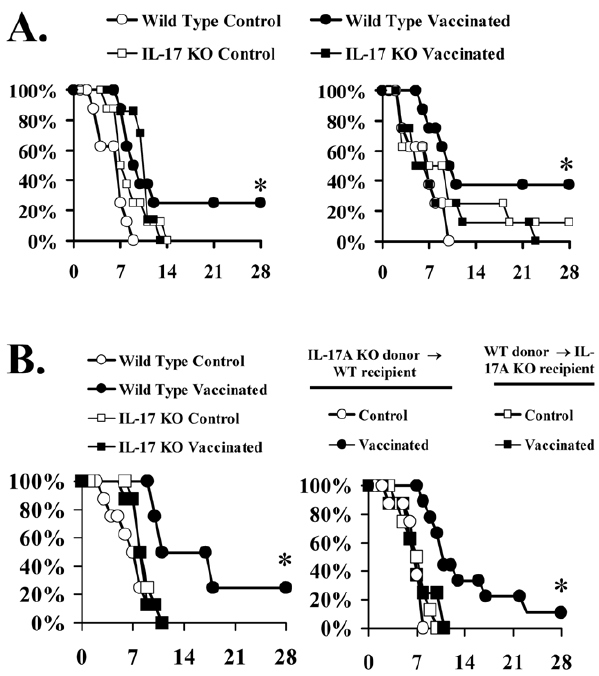
Figure 4. CD4 + T cell derived IL-17A was required for vaccine protection. A) Balb/c or IL-17A deficient mice on a Balb/c background (n=8 per group) were vaccinated with rAls3p-N plus Alhydrogel or Alhydrogel alone, with a boost at 3 weeks. Two weeks after the boost, all mice were infected with 2.5 6 10 5 C. albicans SC5314 or 2 6 10 7 S. aureus LAC. B) Balb/c mice or IL-17A deficient mice on a Balb/c background, n=8 per group, were vaccinated with rAls3p-N plus Alhydrogel or Alhydrogel alone. Two weeks after the boost, splenic and lymph node CD4 + T cells, 5 6 10 6 , from vaccinated or control, wild type or IL-17A-deficient mice were cross-adoptively transferred iv to recipient mice, wild type donor to IL-17A deficient recipient, IL-17A donor to wild type recipient, 24 h prior to infection with C. albicans SC5314, 2.5 6 10 5 inoculum. *p , 0.05 for wild type donor vaccinated vs. control by Log Rank test. Figs. S2 and S3) compared to the frequencies in unvaccinated mice. Murine CD4 + CCR6- cells were enriched for the Th1 phenotype, and CD4 + CCR6 + cells were enriched for the Th17 phenotype. However, a substantial proportion of CCR6 + splenocytes, and particularly CD4 + CCR6 + lymphocytes, were Th1/17 (IFN c + IL-17 + ) cells. The Th1/17 phenotype was predominantly found in CD4 + CCR6 + cells, not in the CD4 + CCR6- cells.